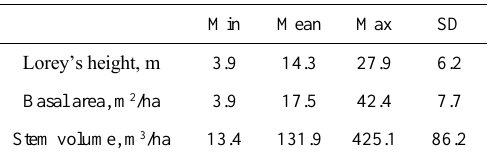
Table 1. Summary of sample plot statistics obtained in field inventories in